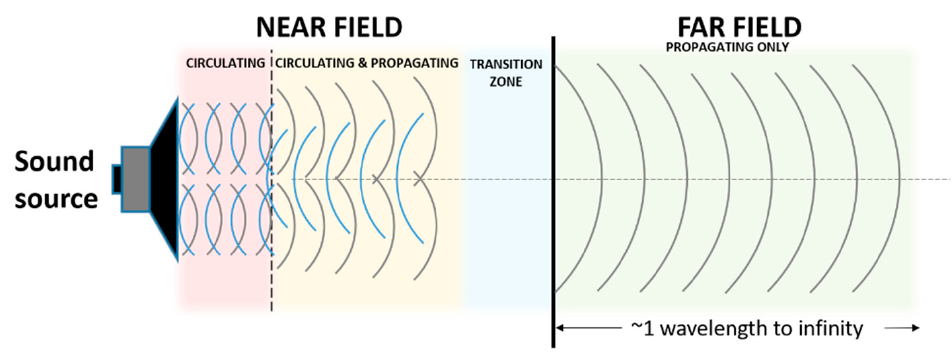
Figure 16. Acoustic sound field consideration [72].